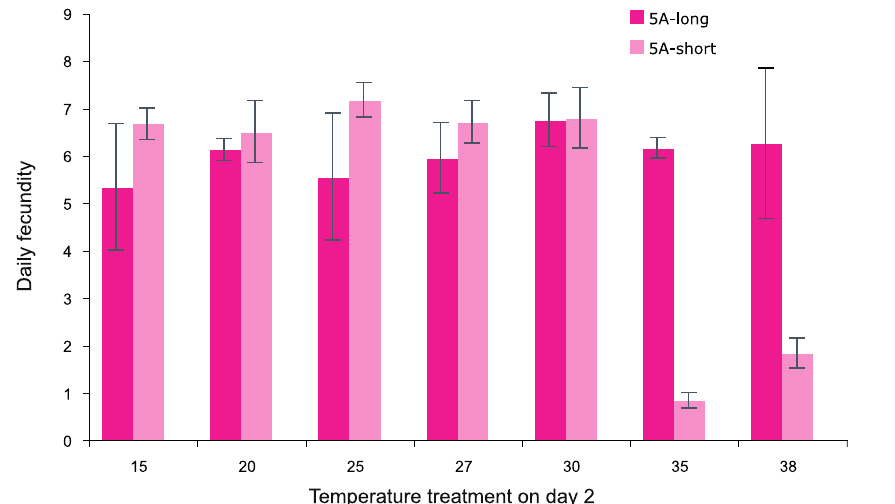
Figure 4. Effect of Different Temperature Treatments on Day 2 on Fecundity as Adults, for Aphid Lines with Buchnera with Different ibpA Promoter Alleles Bars show means 6 standard errors. doi:10.1371/journal.pbio.0050096.g004 PLoS Biology |